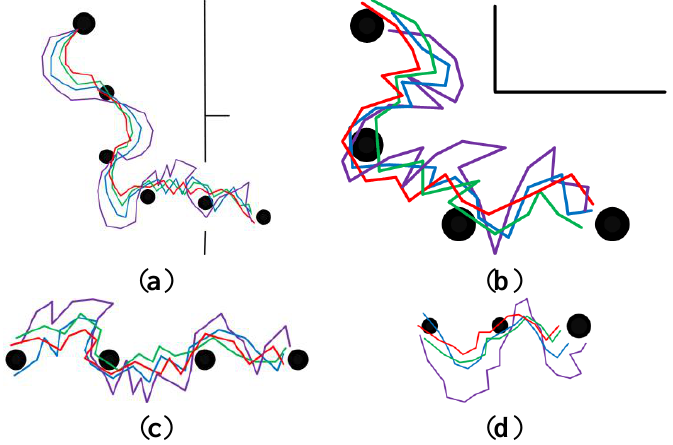
Figure 11. The homing trajectories in modified environments with relatively poor illumination. ( a – d ) show the results obtained in phase 1, 2, 3 and 4, respectively. Red lines correspond to the proposal. Violet lines correspond to SURF. Blue lines correspond to the proposal without selection and updating. Green lines correspond to the proposal without updating. In each figure, the robot moves from left to right, the black disks with the same size are intermediate nodes, and the bigger one is starting node or home node.